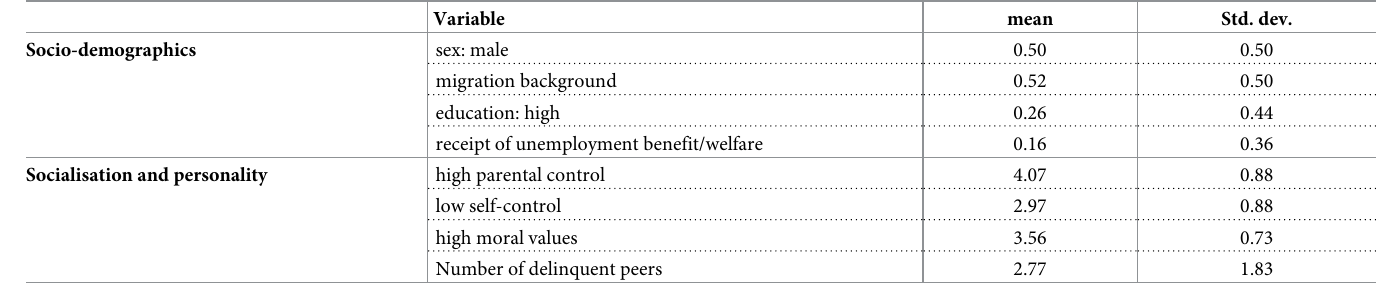
Table 2. Descriptive statistics of the control